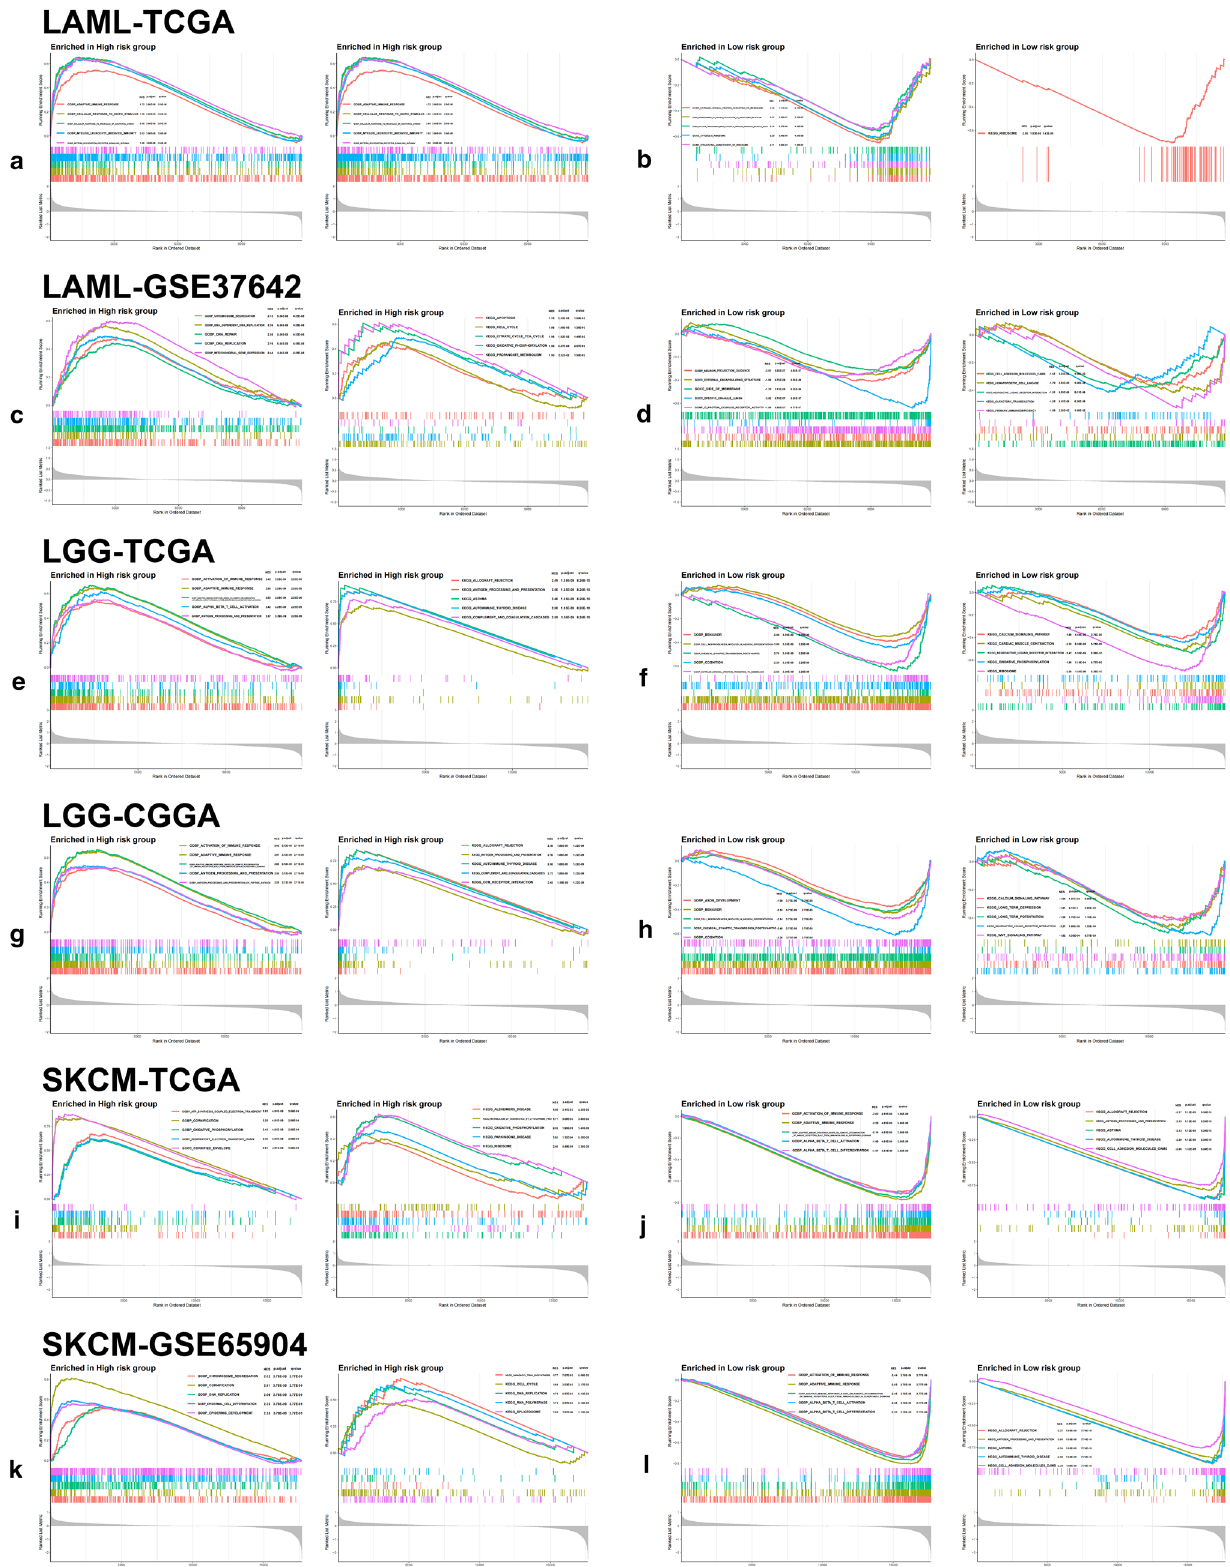
Fig. 8 GSEA in LAML, LGG and SKCM. GSEA shows the top 5 GO and KEGG pathways enriched in low- and high-risk groups of LAML ( a – d ), LGG ( e – h ) and SKCM ( i – l ) at both training and testing sets. NES, adjusted p-value and q-value were marked in the